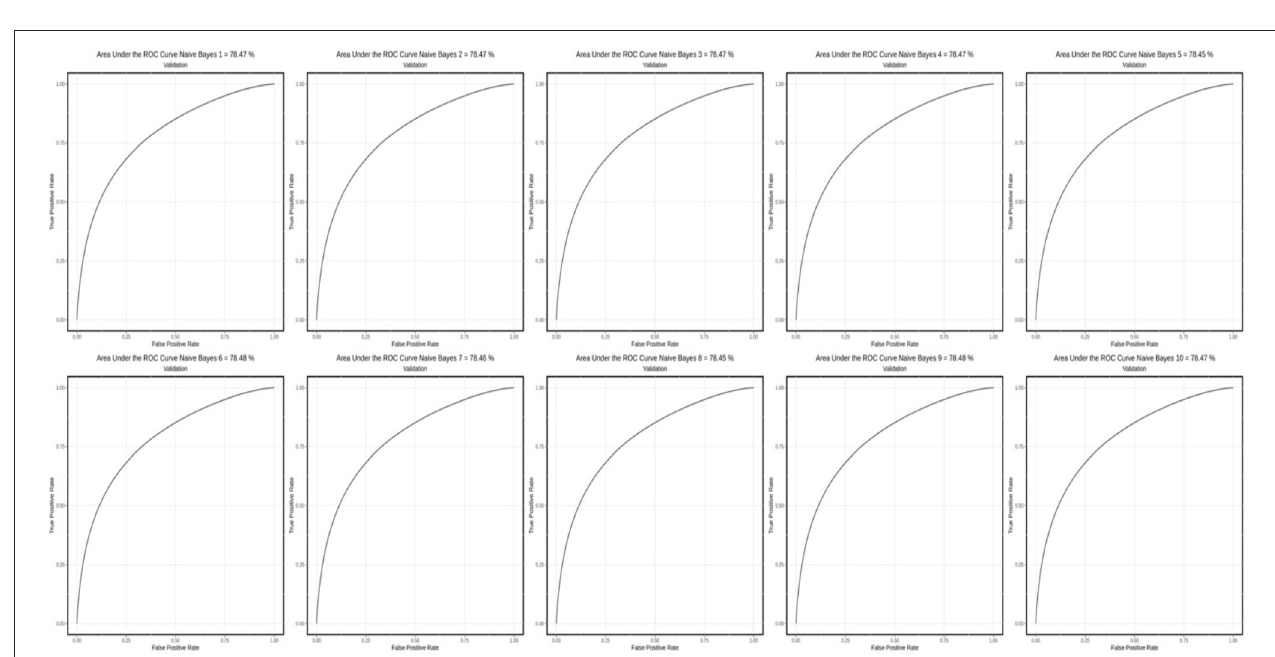
FIGURE 2 | AUC performance on the classification method with the 10-fold CV using the Naïve Bayes method.